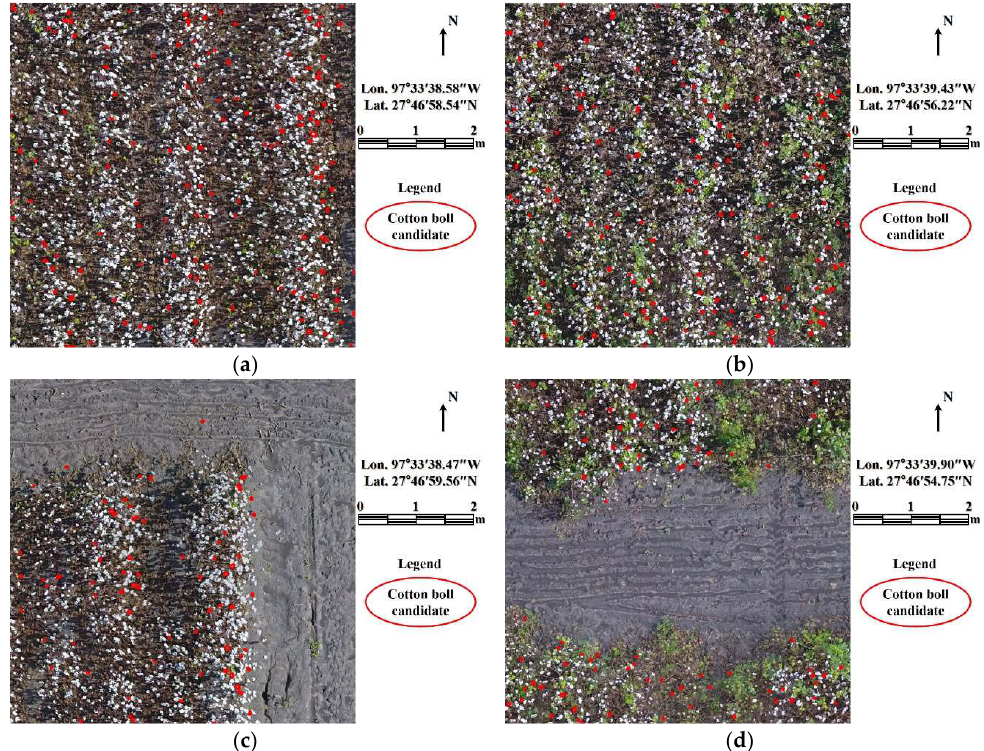
Figure 6. Cotton boll candidate extraction. ( a ) N1; ( b ) S1; ( c ) N2; ( d ) S2.